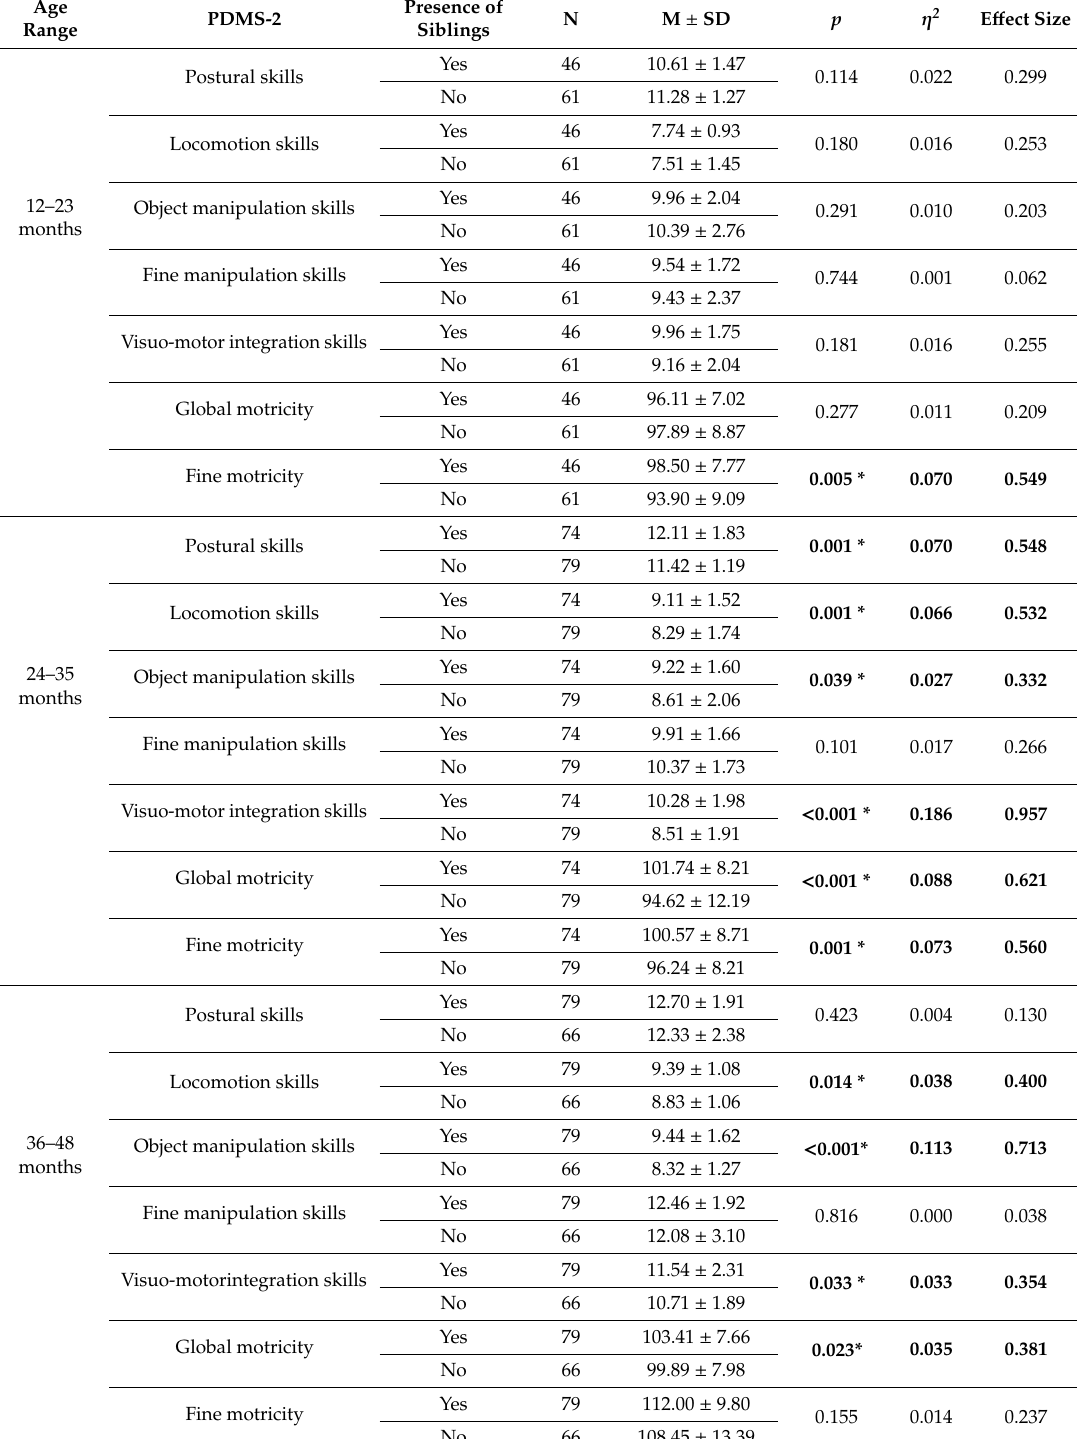
Table 3. Di ff erences regarding the sibling presence variable in the PDMS-2 for each age range. Age